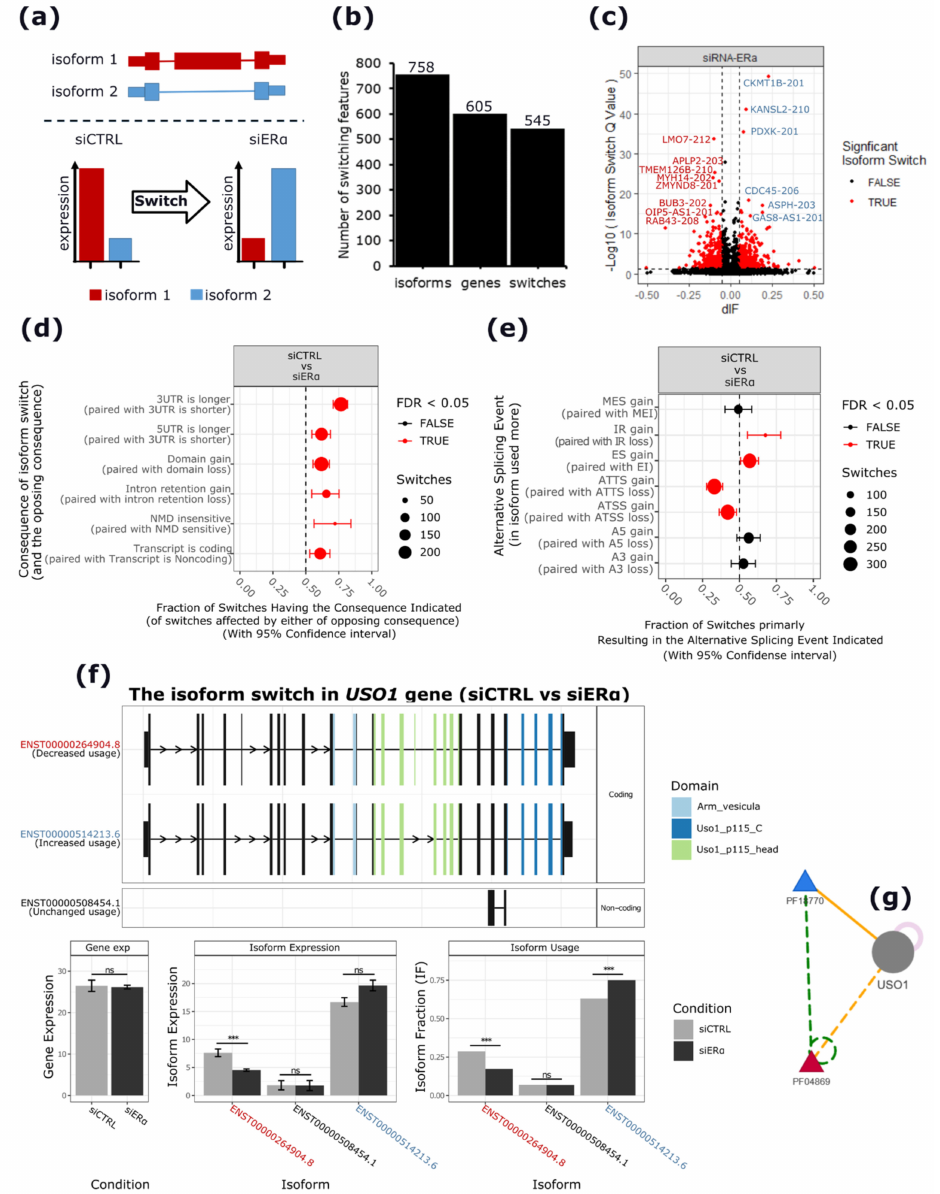
Figure 2. Isoform switching events observed upon apoER α silencing in MCF-7. ( a ) Scheme depicting the principle behind differential isoform usage (dIU) analysis. ( b ) Bar plots reporting the number of significantly switching genes and isoforms involved in switching events. ( c ) Volcano plot reporting the differential isoform fraction (dIF) and relative significance ( − log10(adj. p.)) of switching isoform pairs. The top significant switches are labeled accordingly. ( d ) Plot showing the fraction of switches affected by either of the opposing consequences (x-axis) for each pair of opposite consequences (y-axis). Fractions significantly different from 0.5 indicated an enrichment of isoforms with the indicated consequences. ( e ) ASEs enrichment analysis reporting the fraction of switches resulting from each specific ASE, such as MES/MEI, multiple exon skipping/inclusion; ES/EI, exon skipping/inclusion; A5 (cid:48) /A3 (cid:48) , alternative 5 (cid:48) /3 (cid:48) splice sites; IR, intron retention; ATTS/ATSS, alternative transcription termination/start sites. ( f ) Isoform switching plot for USO1 gene. Upper panel shows the isoforms involved in the switch and the encoded protein domains. Histograms show the gene and isoform expression levels in normalized TPM units and their DE status (ns, not significant; ***, p < 0.0001). ( g ) Downstream effects of USO1 isoform switching event. Triangles represent the protein domains of the protein (grey circle). The domain encoded by the skipped exon is highlighted in red whereas its interacting domain is in blue. Dashed lines represent the suppressing effects of the ES